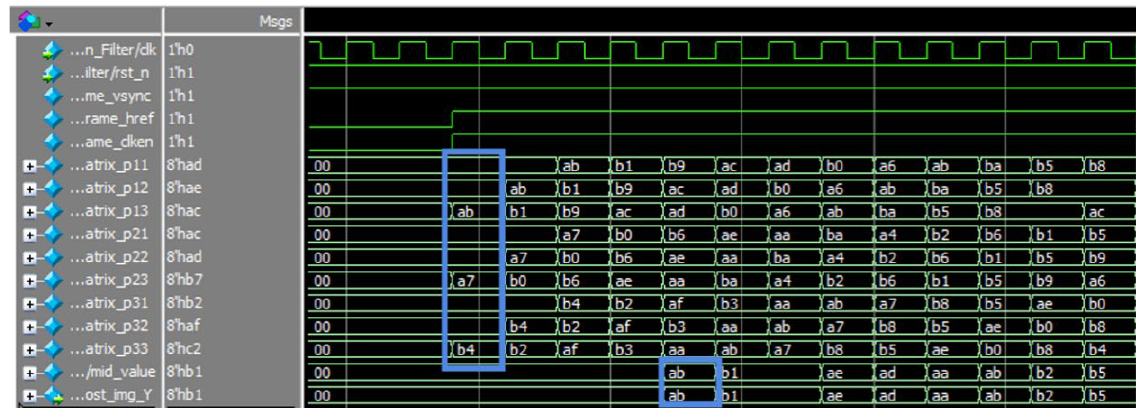
Figure 6. FPGA-based image processing algorithm RTL diagram.